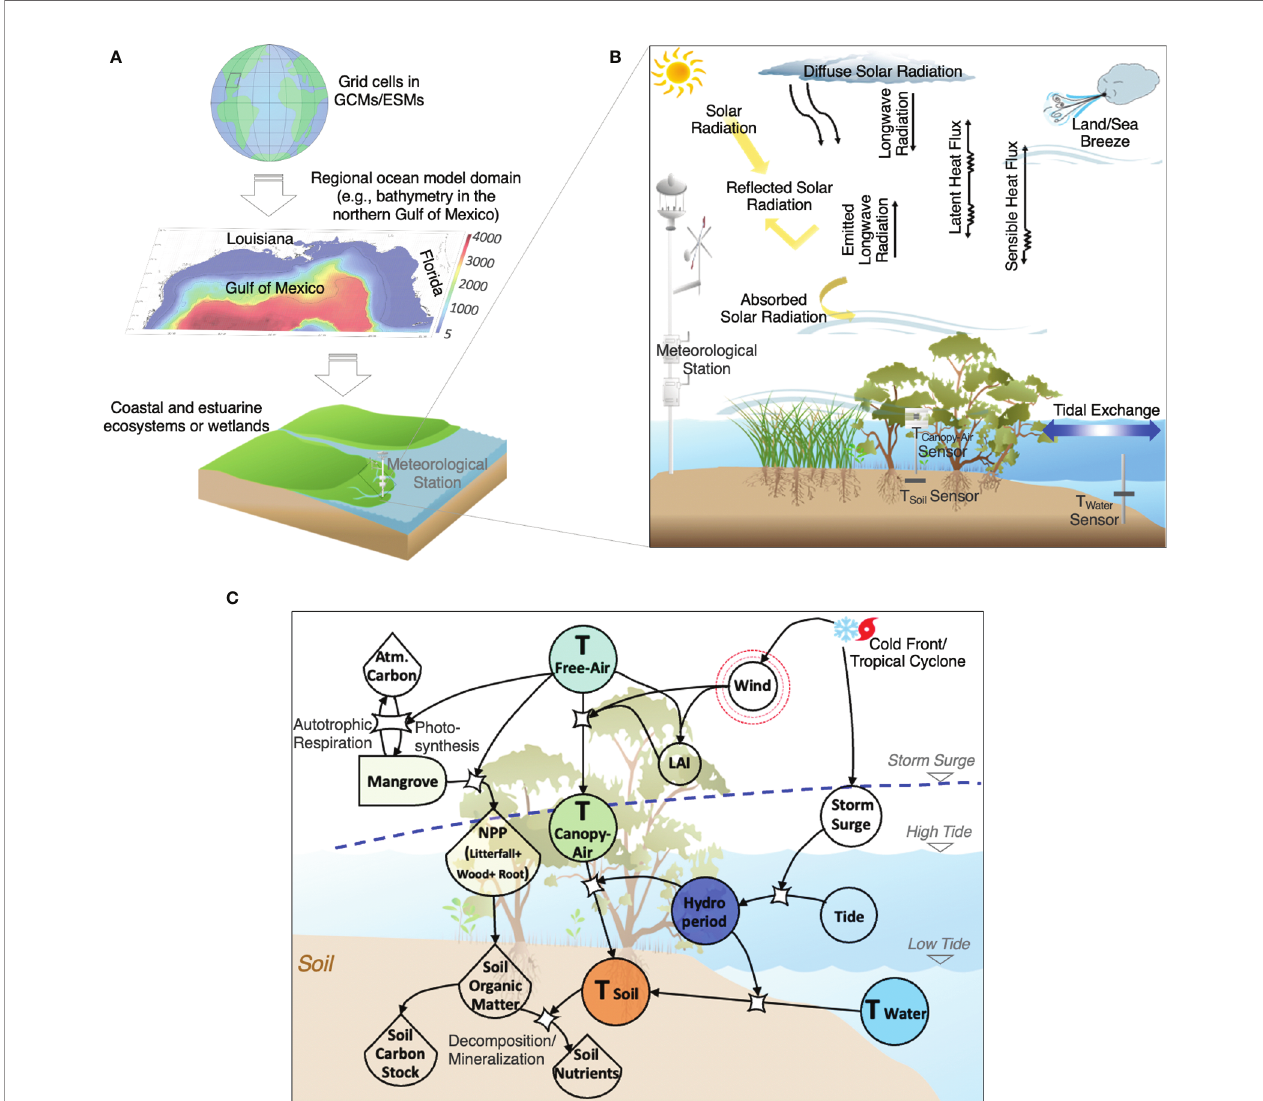
FIGURE 1 | Conceptual diagram showing (A) grid cell in General circulation models (GCMs) or Earth system models (ESMs) downscaled to the regional ocean model domain (e.g., bathymetry in the northern Gulf of Mexico) and coastal/estuarine ecosystems or wetlands; (B) energy fl uxes near ground in coastal wetlands, and (C) biogeochemical cycling in coastal wetlands regulated by local hydroperiod and microclimate temperature (i.e., soil and canopy air) under impacts of regional free-air temperature and extreme weather events, including tropical cyclones and cold fronts. The panel (B) is modi fi ed from Bonan (2008). Symbols in panel (C) are from Odum ’ s Energy Systems Language and the Integration and Application Network (https://www.osti.gov/biblio/5545893; https://ian.umces.edu/symbols). Abbreviations in panel (B, C) : T, Temperature; Atm., Atmosphere; NPP, Net primary productivity; LAI, Leaf area